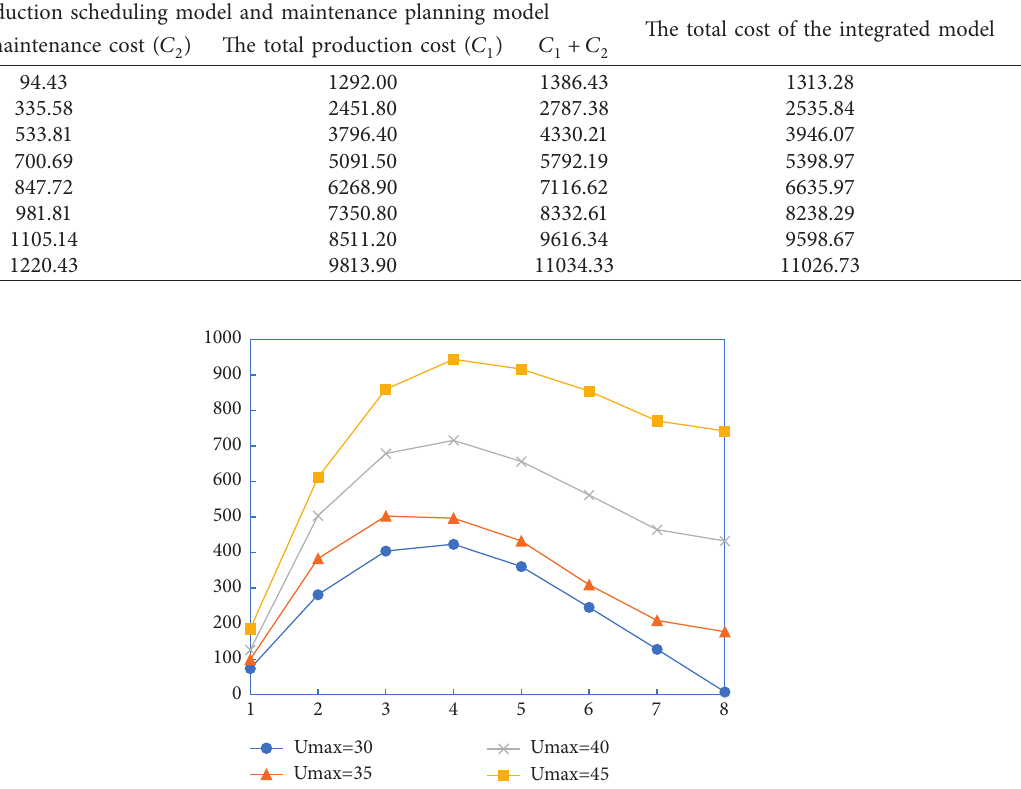
and N on diff . max